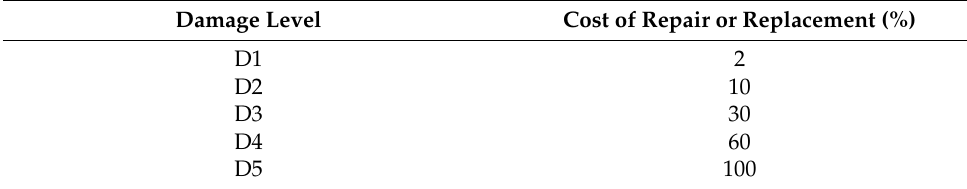
Table 5. Matrix 2—Percentage of cost of repair or replacement. Reprinted with permission from [19].